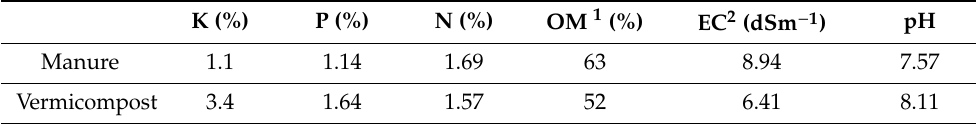
Table 2. Some physico-chemical properties of organic fertilizers used in the trial.